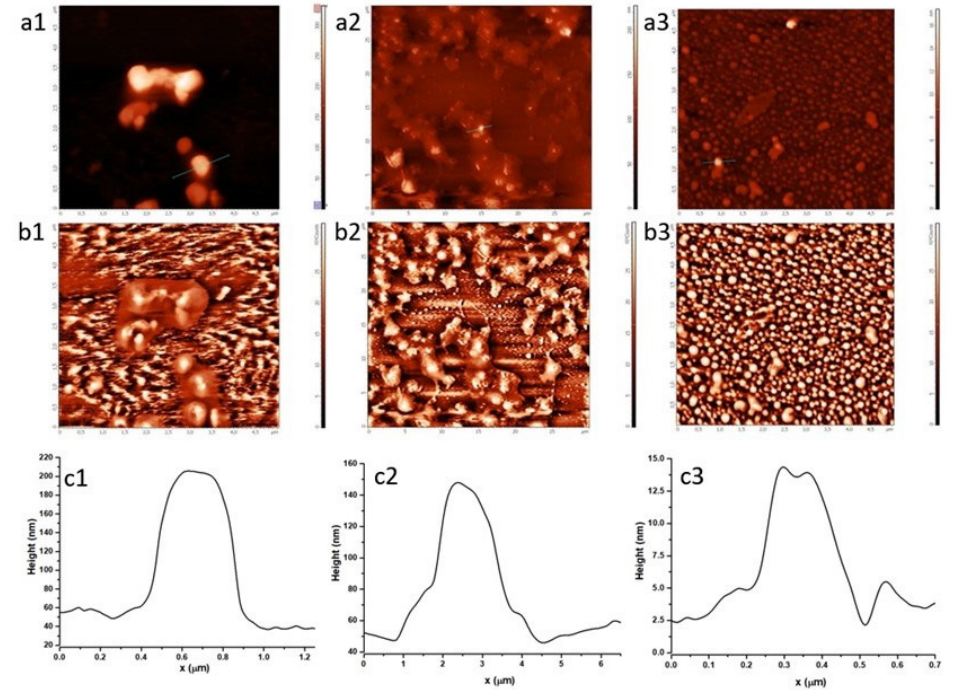
Figure 2. The topography ( a1 – a3 ) and contrast phase ( b1 – b3 ) images and the profiles ( c1 – c3 ) of simple Fh-NPs, doped with Co, and Cu Fh-NPs coated with human serum albumin (HSA), deposited on mica substrate.